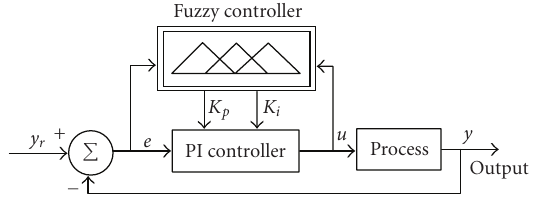
Figure 1: Fuzzy-coordinated PI controller structure.